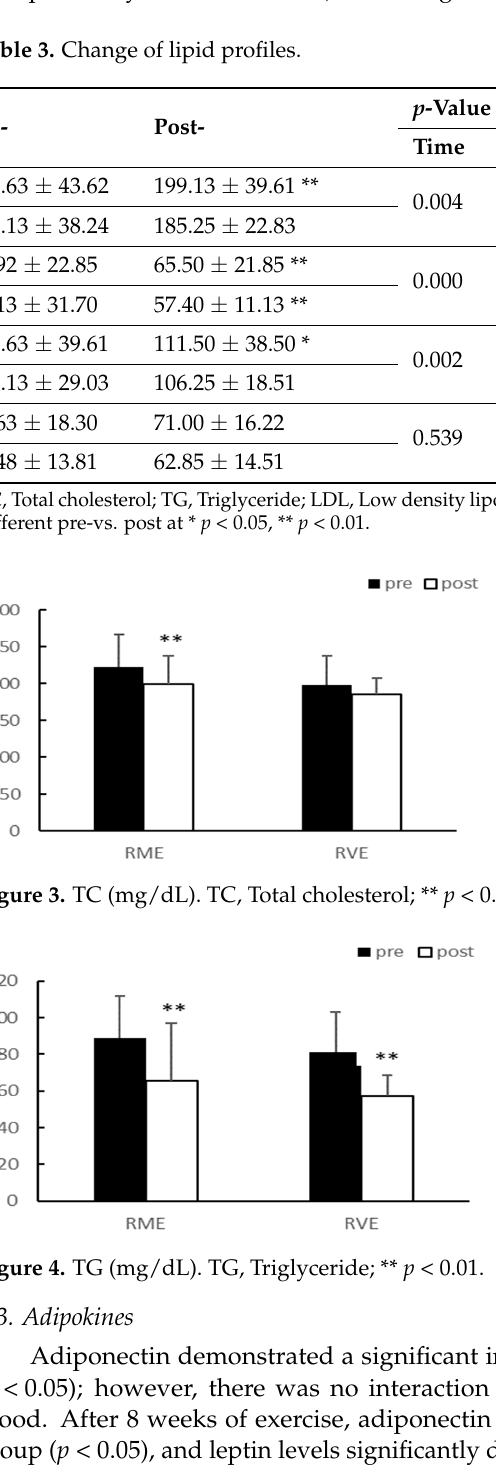
Figure 5. LDL (mg/dL). LDL, Low-density lipoprotein; * p < 0.05. Figure 6. HDL (mg/dL). HDL, High-density lipoprotein. 3.3. Adipokines Adiponectin demonstrated a significant interaction effect between group and time ( p < 0.05); however, there was no interaction effect on the leptin concentration in the blood. After 8 weeks of exercise, adiponectin levels significantly decreased in the RVE group ( p < 0.05), and leptin levels significantly decreased in both groups ( p < 0.05) (Table 4, Figures 7 and 8). The fasting glucose level did not reach statistical significance after exercise, de- spite exhibiting a decreasing trend.